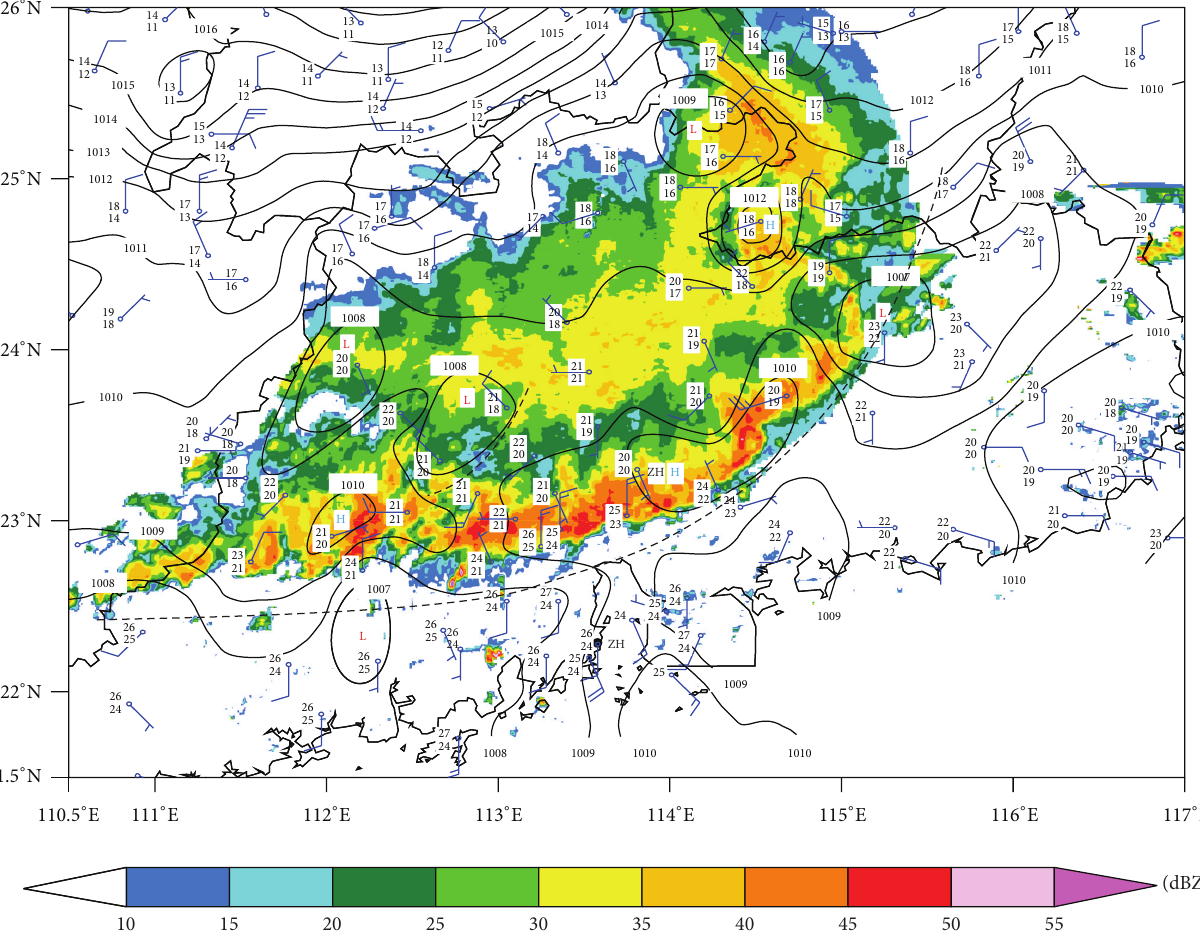
Figure 5: Surface chat at 0800 LST 24 April 2007. The colour shading is radar reflectivity (dBZ) at 2km height. Solid contours are pressure field (hPa). Dashed lines indicate the two surface convergence lines. Temperature and dew point ( ∘ C) are given at individual weather station.